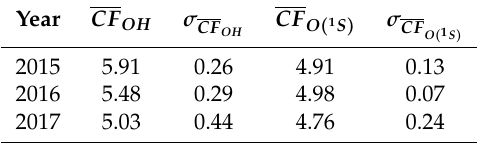
Table 6. Magnitude of the weighted mean and standard deviation for OH and O ( 1 S ) emissions. CF O ( 1 S ) σ Year CF OH σ CF OH CF O ( 1 S )